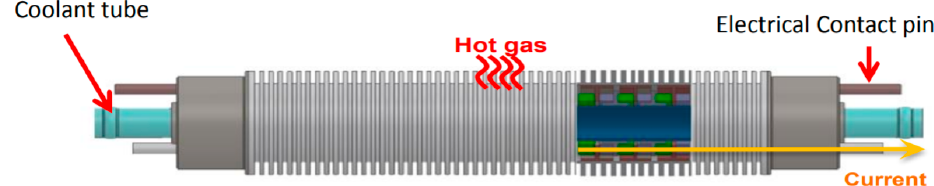
Figure 6. Typical cylindrical TEG for an automotive exhaust showing the stacked TE elements, with inner and outer fins as heat exchangers [46].